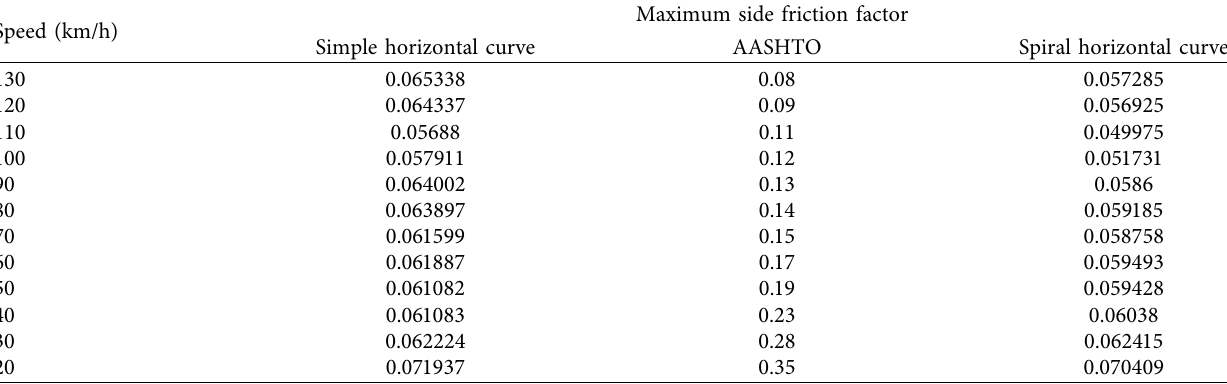
Table 13: Comparison of the maximum side friction factor between simple and spiral horizontal curves and AASHTO recommended values for sedan at a radius of 1.1 R.